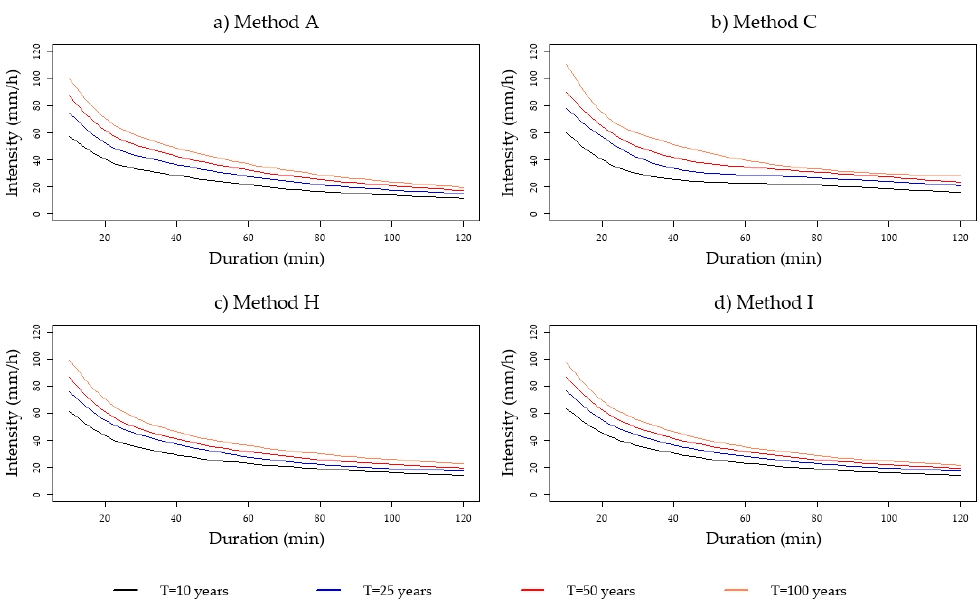
Figure 8. Established comparison of the IDF relationship estimated through different methods for station 2035 for different return periods. Figure 8a shows the IDF curves from method (A), estimated from pluviograph records using Gumbel (Equation (1)). Figure 8b shows the IDF curves from method (C) estimated from isohyetal map of the SCT. Figure 8c shows the IDF curves from method (H) estimated from the average of IDF developed by methods A, B, C, D, E, and F, and Figure 8.d shows the IDF curves from method (I) estimated from Chen equation using the ( R ) ratio proposed (Equation (8)).